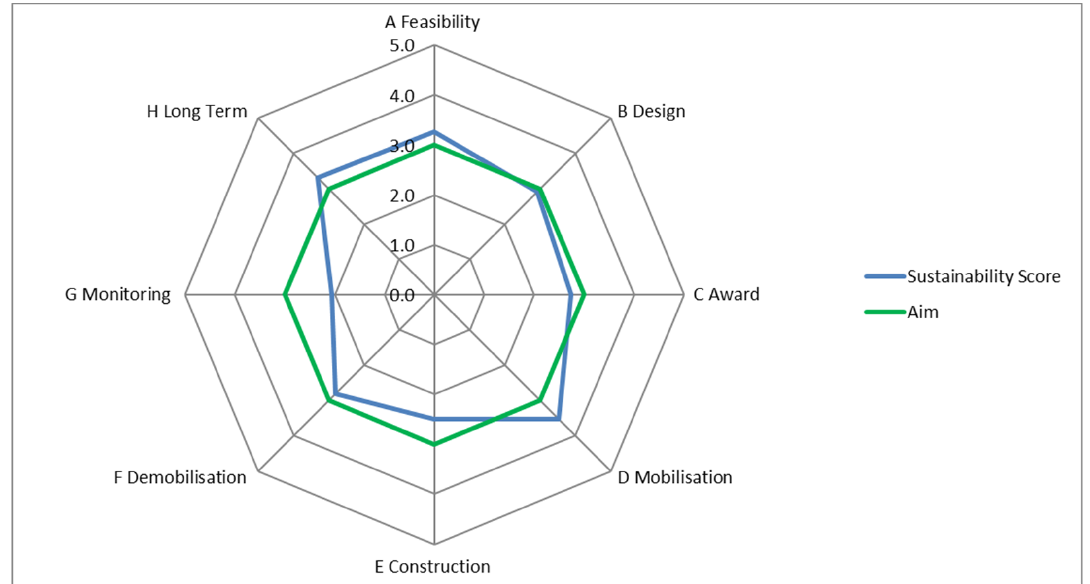
Figure 3. Average scores for fluvial case studies (10).